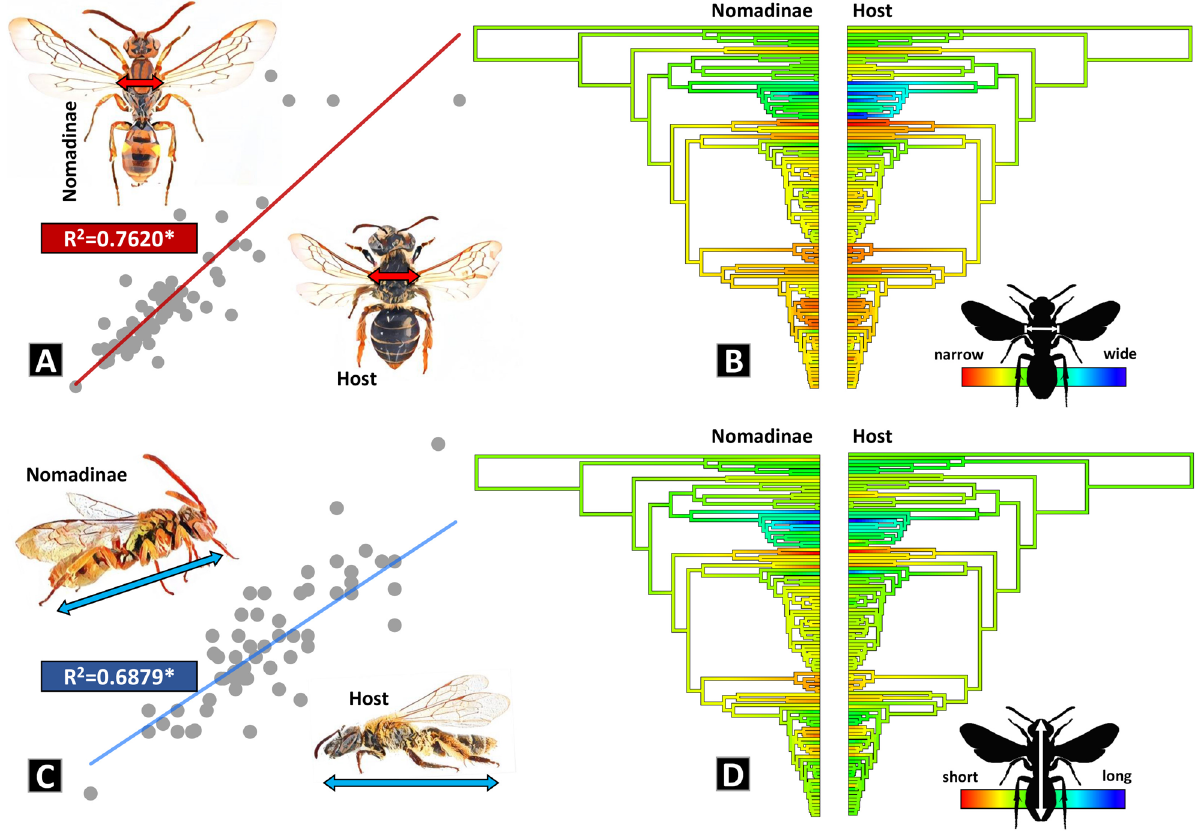
Figure 3. Size correlation between cuckoo bees and hosts. ( A ) Linear regression analysis of ITD (R 2 = 0.7620, P < 0.05). ( B ) Ancestral character estimation of body width (ITD) of cuckoo bees (left) in accordance with size of the hosts (right). ( C ) Linear regression analysis of entire body length (R 2 = 0.6879, P < 0.05). ( D ) Ancestral character estimation of body length of cuckoo bees (left) in accordance with size of the hosts (right). Illustrations in ( A , C ) were converted from photographs obtained by the first author using PRISMA mobile